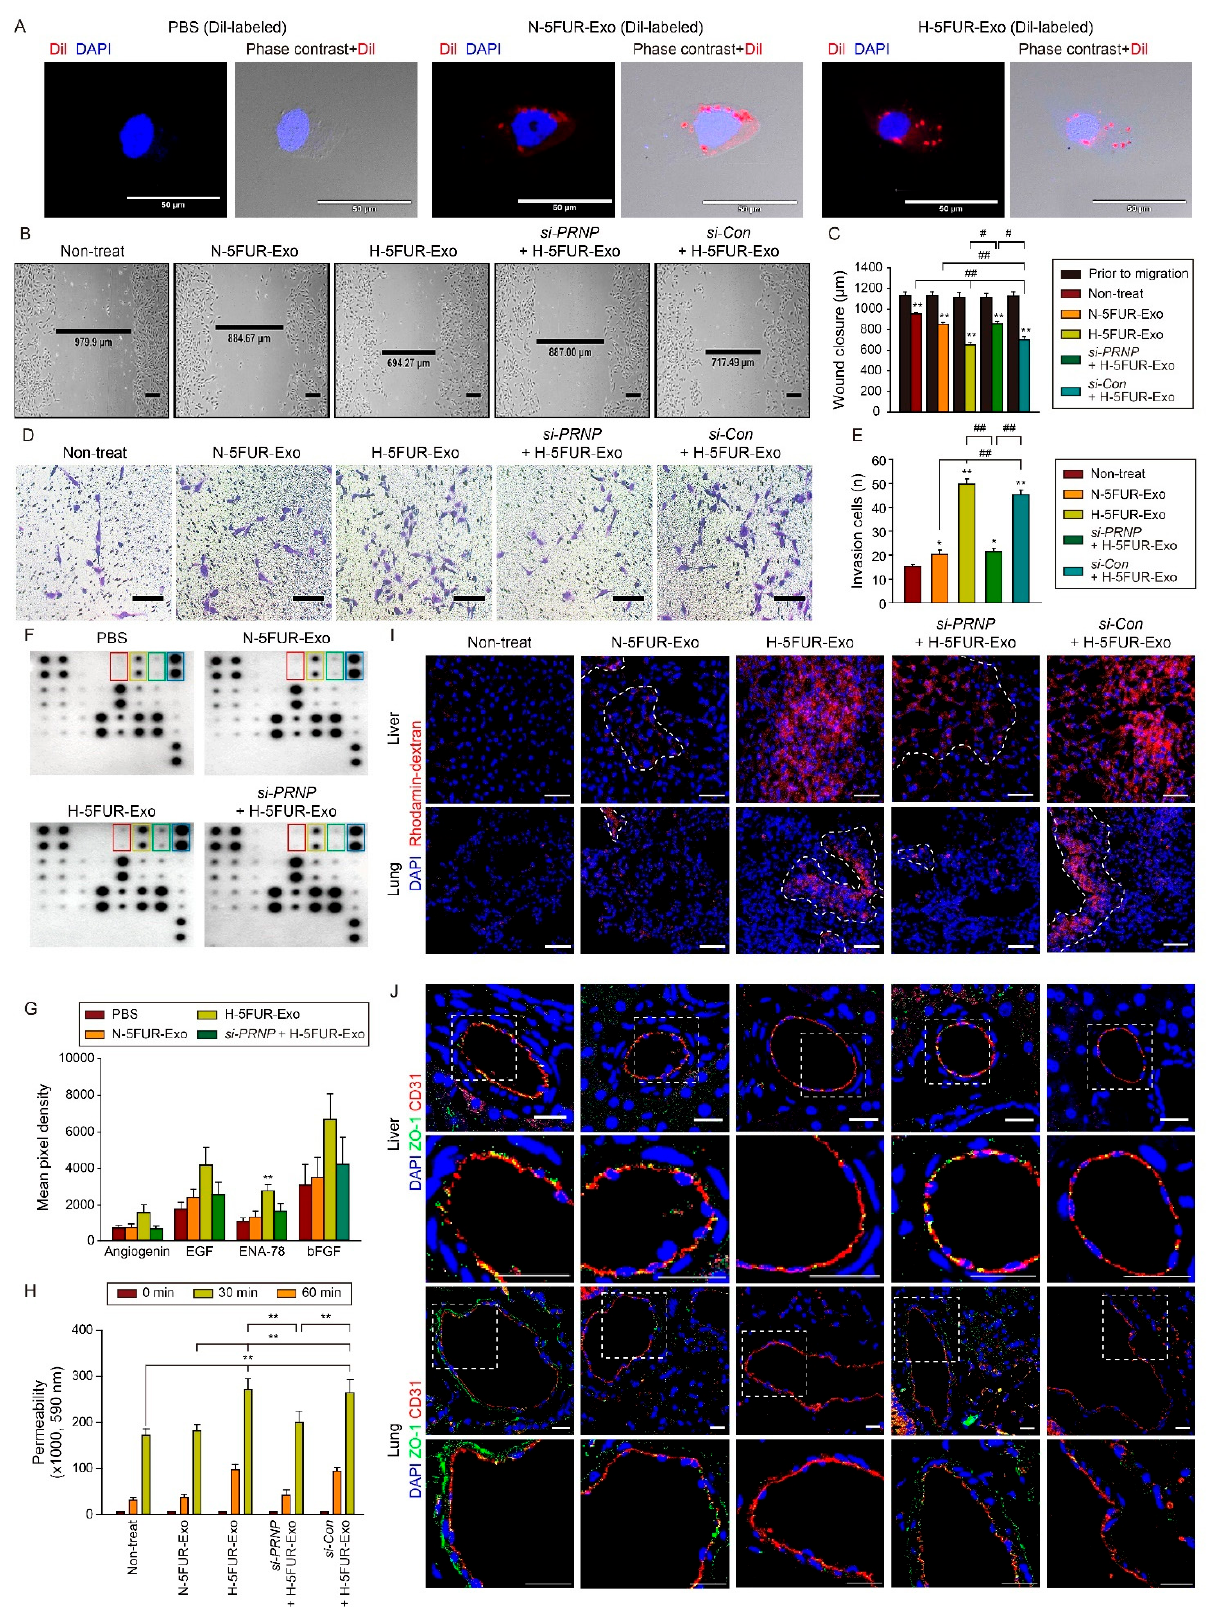
Figure 5. Uptake of exosomes into HUVECs and their effect on HUVECs and blood vessels. ( A ) Representative immunofluorescence analysis of intracellular uptake of DiI-labeled exosomes (red) to HUVECs. Scale bar = 50 µ m (n = 3). ( B ) Representative wound healing assay of HUVECs treated with exosomes isolated from SNU-C5/5FUR under normoxic and